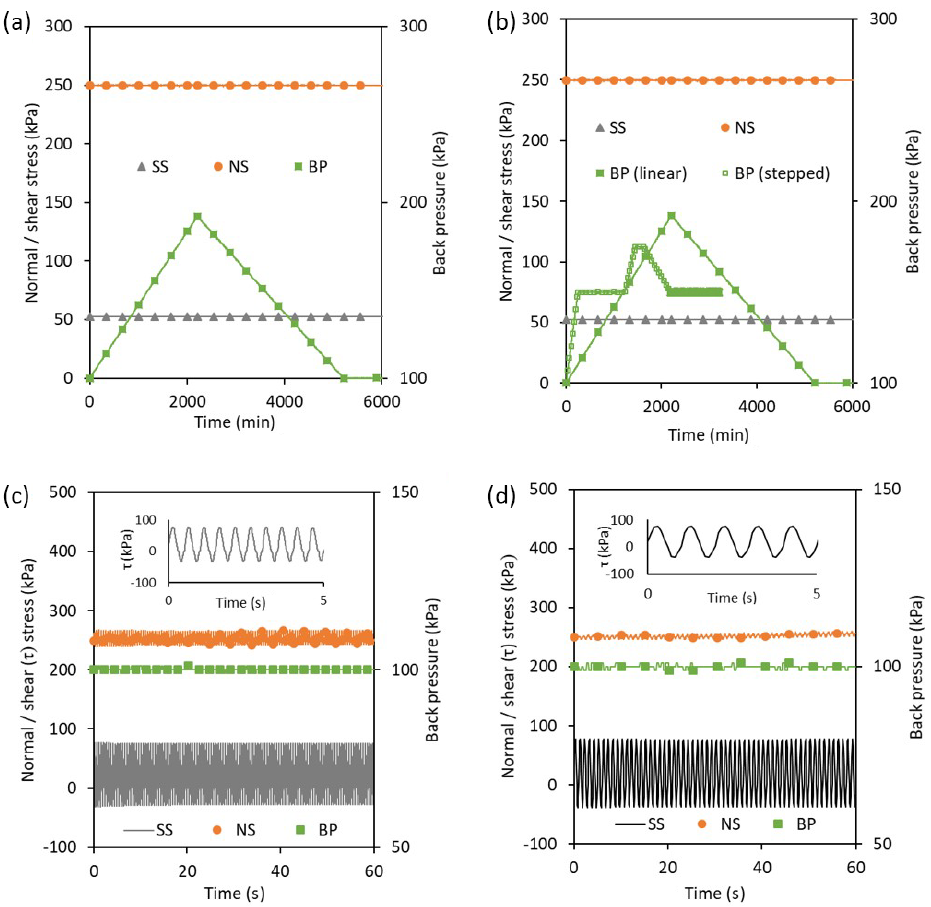
Figure 4. Simulations of porewater pressure and earthquake-induced landslide movement mechanisms in the dynamic back-pressured shear box. (a) Linear increase and decrease in applied porewater pressure (back pressure, BP) at constant normal stress (NS) and shear stress (SS) from an initial mean effective stress of 400kPa. (b) Linear (UTD PP1) and stepped (UTD PP2) increases and decreases in back-applied porewater pressure at constant normal stress and shear stress from an initial mean effective stress of 150kPa. (c) Dynamic stress-controlled shear experiments conducted at a frequency of 2Hz. (d) Dynamic stress-controlled shear experiments conducted at a frequency of 1Hz.